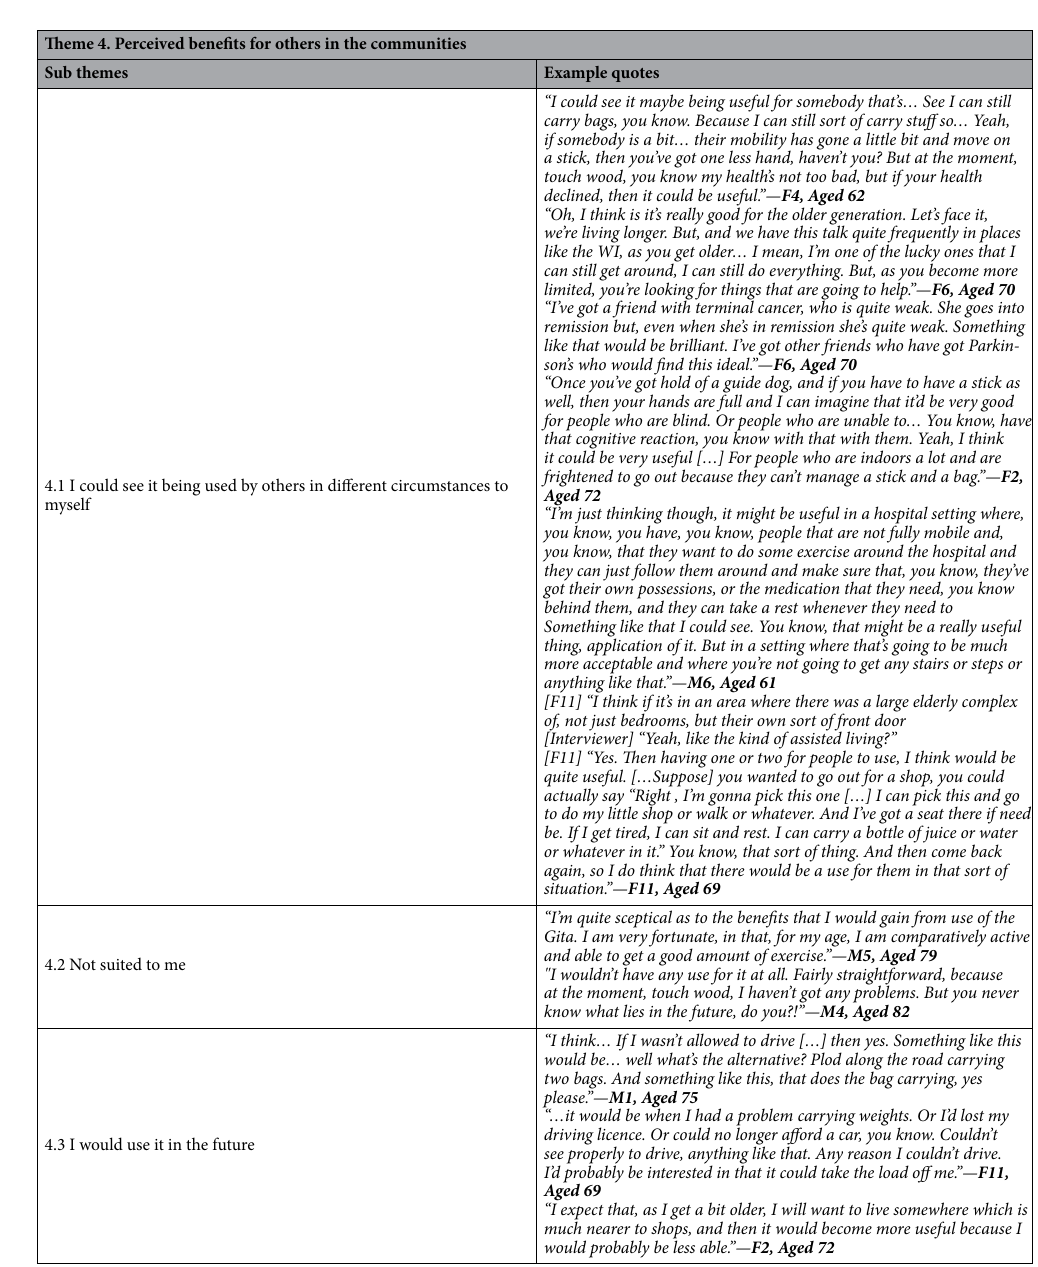
Table 5. Example quotes of Theme 4. Facilitating social